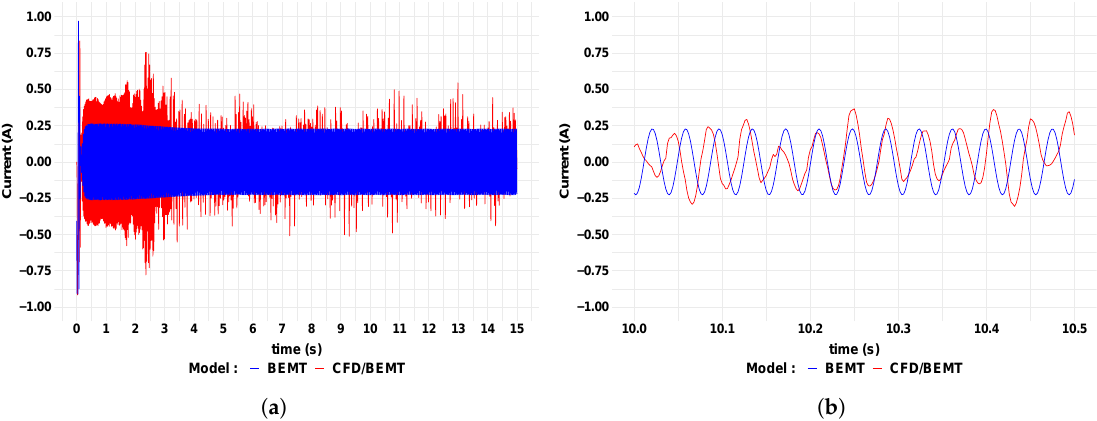
Figure 14. Generator phase current at Uo = 0.6 m/s for ( a ) 15 s and ( b ) between 10.0 s and 10.5